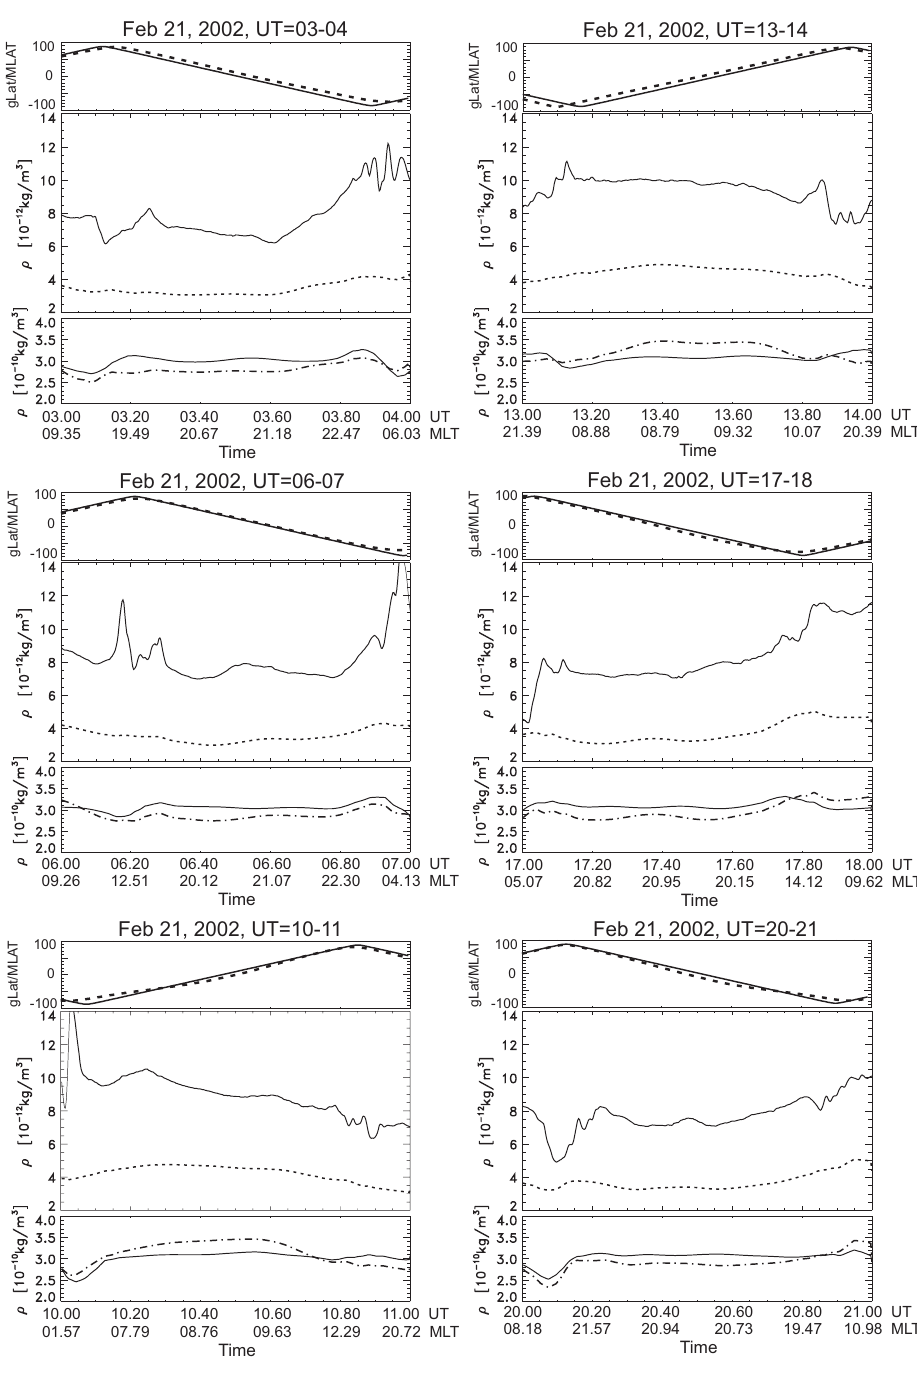
Fig. 9. Comparison between CHAMP and TGCM results for six 1-h intervals on 21 February 2002, upper panels: satellite orbit as a function of time and geographic (solid) and magnetic (dashed) latitude, middle panels: CHAMP-derived densities (solid) and TGCM densities at 430km altitude (mean satellite height) (dashed), lower panels: TGCM densities at 200km altitude (solid) and 300km altitude (dash-dotted). The values at 300km have been multiplied by 10 in order to fit into the same density scale.